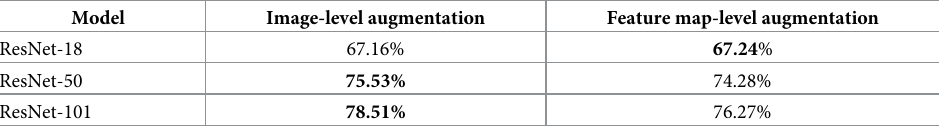
Table 7. Augmentation performance using the ResNet architecture on the CIFAR-100 dataset when classifying the image and feature